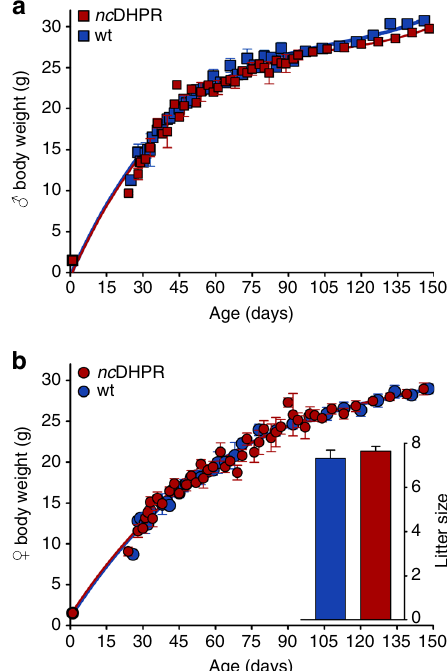
Fig. 4 Lack of DHPR Ca 2+ in fl ux has no impact on body weight development and fertility. Growth curve of ( a ) male and ( b ) female nc DHPR and wt mice was monitored weekly for 150 days. a Male nc DHPR ( n = 30) and wt ( n = 35) siblings showed identical ( P > 0.05) body weight development. b Similarly, female nc DHPR ( n = 29) showed no difference ( P > 0.05) in body weight development compared with their wt control siblings ( n = 31). At the end of the observation period, the maximum body weight of male nc DHPR and wt mice was 29.76 ± 0.55 and 30.74 ± 0.54 g, respectively, and of female nc DHPR and wt mice was 28.96 ± 0.73 and 28.98 ± 0.60 g, respectively. b ( Inset ) The mean litter size of nc DHPR mice (7.64 ± 0.21; n = 100) was similar ( P > 0.05) to wt mice (7.31 ± 0.37; n = 49). Data are represented as mean ± s.e.m.; P determined by unpaired Student ’ s t -test